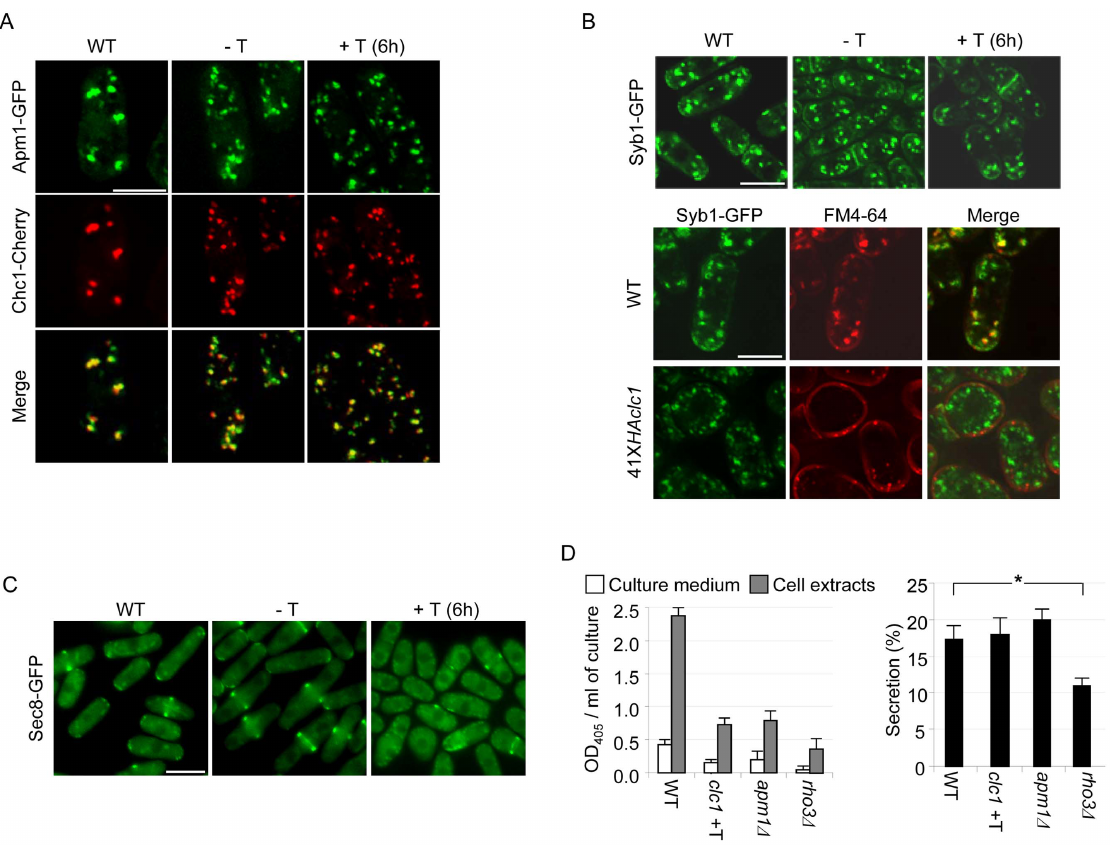
Figure 6. Analysis of general secretion in 41X HAclc1 cells. A. Micrographs of wild-type (WT) and 41X HAclc1 cells bearing Apm1-GFP and Chc1- mCherry fusion proteins; cells were incubated in the absence ( 2 T) and the presence ( + T) of thiamine for 6 hours. The micrographs are projections of z-stack images taken with a DeltaVision deconvolution microscope. B. Upper panels, micrographs of wild-type (WT) and 41X HAclc1 cells bearing Syb1-GFP incubated in minimal medium in the absence ( 2 T) and the presence ( + T) of thiamine for 6 hours. The micrographs are medial sections. Lower panels, the same as before but the cells were incubated in the presence of thiamine and sorbitol for 48 hours. C. Micrographs of the indicated strains carrying a Sec8-GFP fusion protein; the photographs were taken with a conventional fluorescence microscope. Bars, 10 m m. D. Acid phosphatase activity was measured in the culture medium and cell extracts as indicated in Materials and methods; all samples were collected from logarithmic cultures at a density of 2 6 10 7 cells per ml. Left panel, activity as arbitrary units in the culture medium and cell extracts from the indicated strains grown in the presence of thiamine for 6 hours. The activity in the cell extracts was estimated per number of cells in the same volume of culture that was used to estimate activity in the medium, so that both data can be compared directly. Right panel, the secretion of acid phosphatase was calculated as the percentage of activity in the culture medium with respect to the total activity detected (activity in the medium plus activity in cell extracts). The experiment was performed a minimum of five times with duplicates; statistically significant defects are indicated (*; p , 0.05; Student’s t-test).